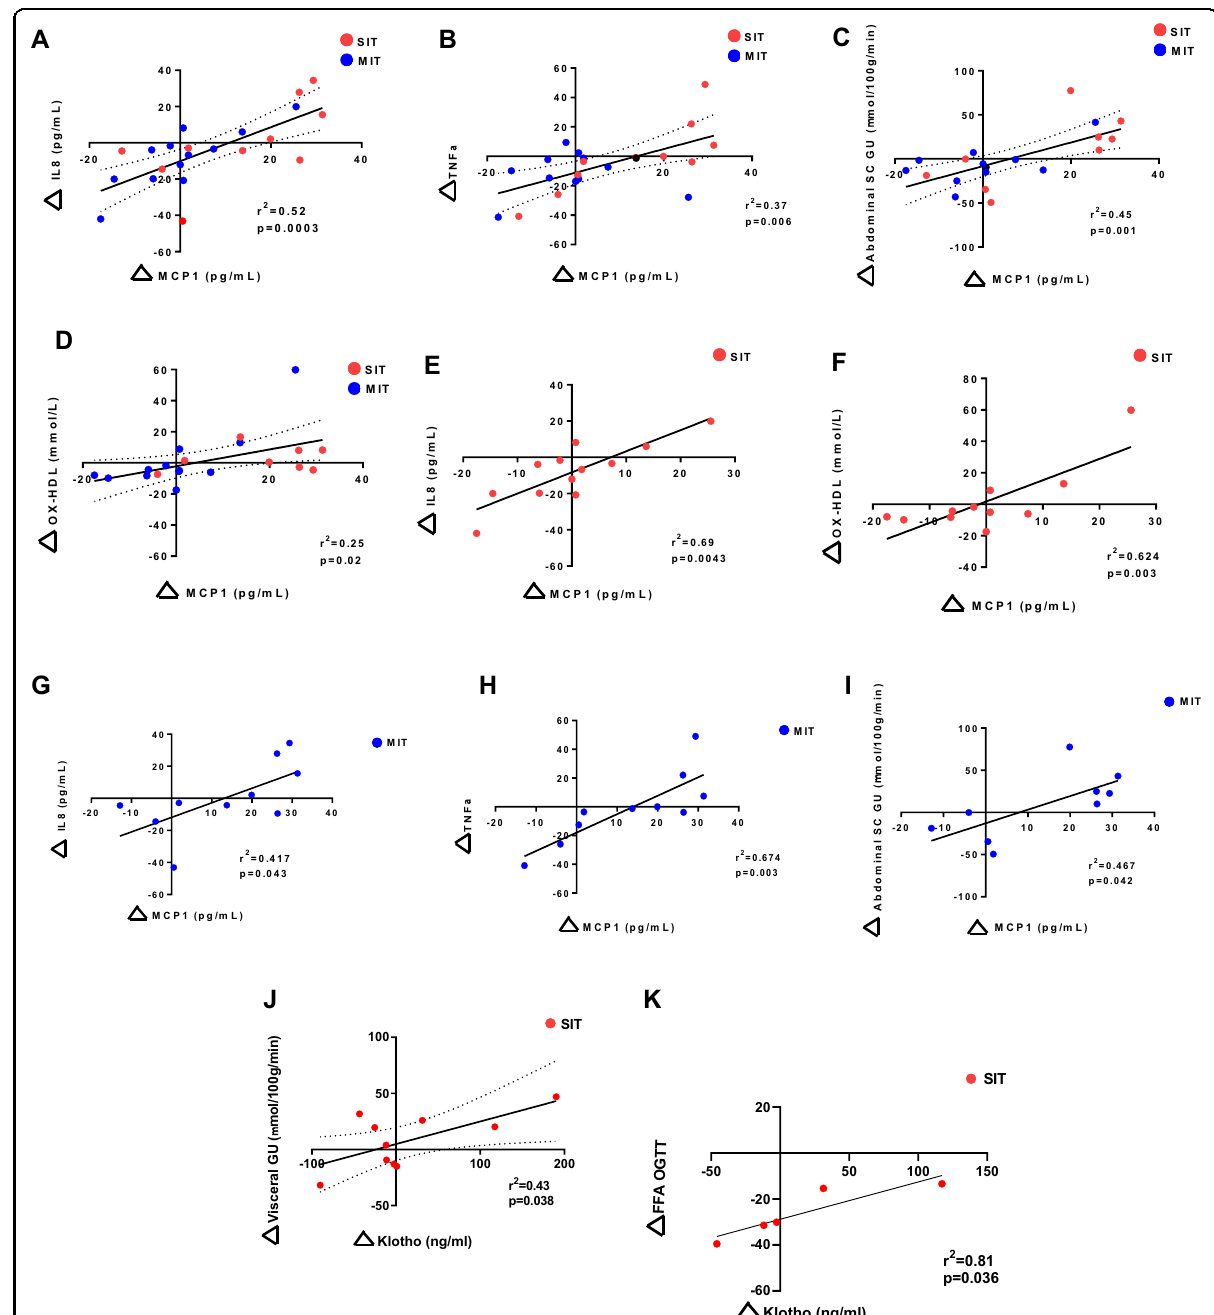
Fig. 3 Correlations between change in MCP-1 and Klotho concentrations with change in metabolic parameters. Pearson ’ s correlations between change in concentrations of MCP-1 in both training groups with change in concentrations of IL8 ( a ), TNF- α ( b ), change in abdominal subcutaneous adipose tissue glucose uptake ( c ), and oxidized HDL ( d ) in both training groups combined. Correlation after sprint interval training (SIT) between change in MCP-1 concentrations and change in concentrations of IL8 ( e ) and Oxidized HDL ( f ). Correlation after moderate intensity training (MIT) between change in MCP-1 concentrations and change in concentrations of IL8 ( g ), TNF- α ( h ), and change in abdominal subcutaneous adipose tissue glucose uptake ( i ). Correlation after SIT training between change in Klotho concentrations and change in visceral subcutaneous adipose tissue glucose uptake ( j ) and free fatty acids measured during oral glucose tolerance test ( k ). N = 9 –